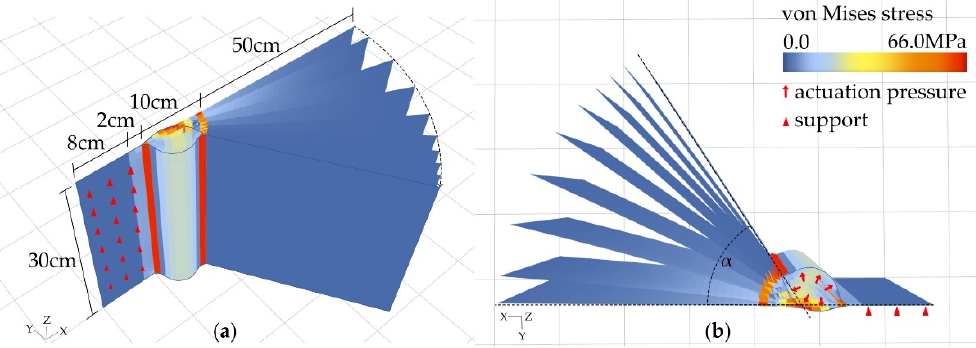
Figure 4. Simulation principle shown on test with 2 + 4 layers and a hinge width of 10 cm, ( a ) perspective view and ( b ) top view.